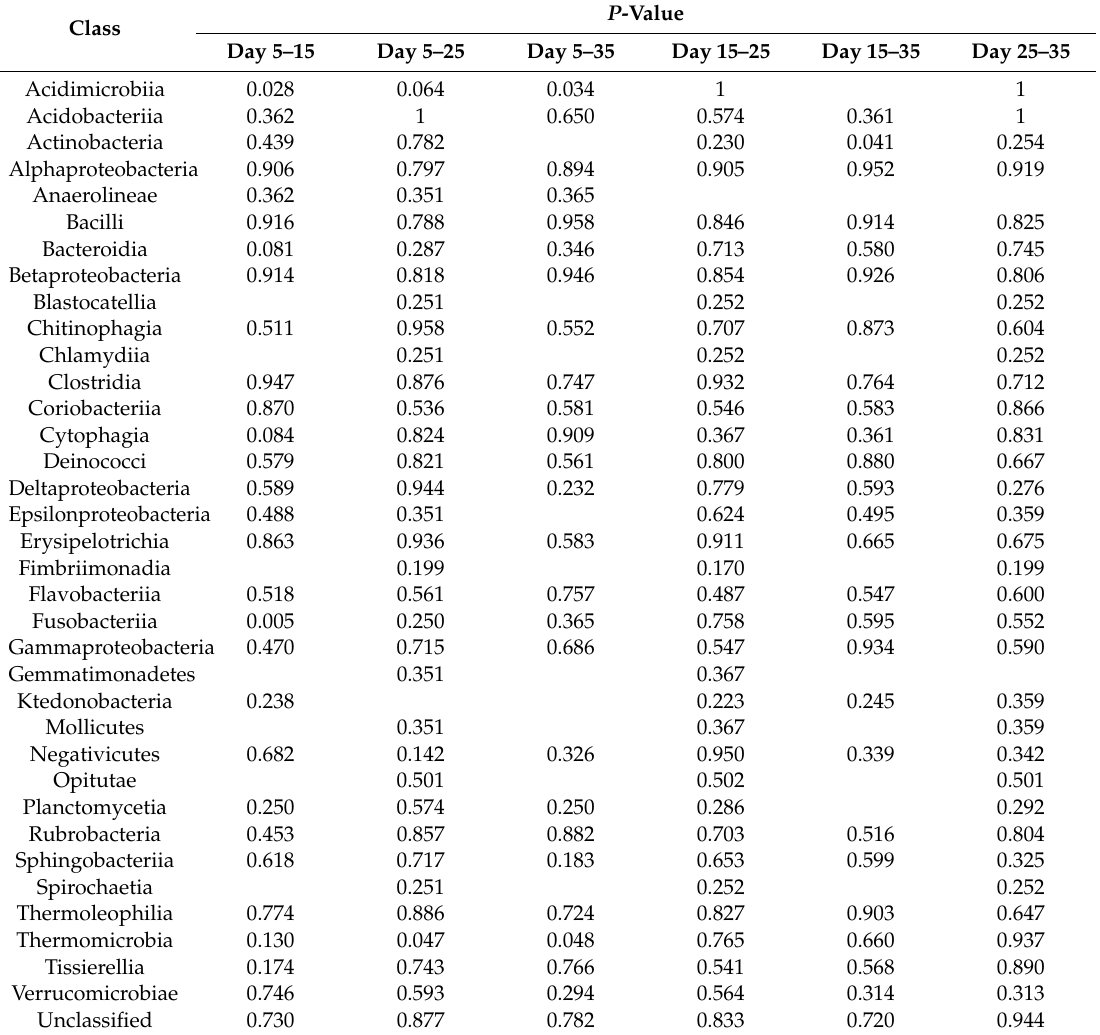
Table 12. P -value distribution of 16S rDNA gene sequence libraries compared the abundance di ff erences of microbial communities among samples from di ff erent age periods for local Omani